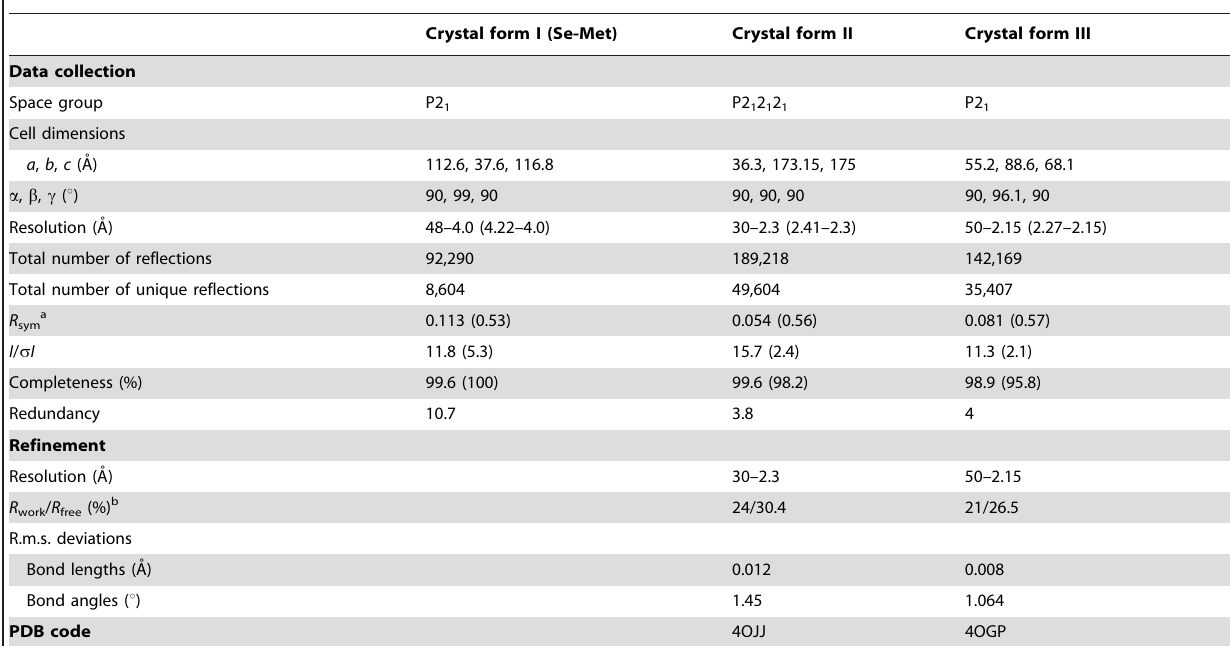
Table 1. Data collection and refinement